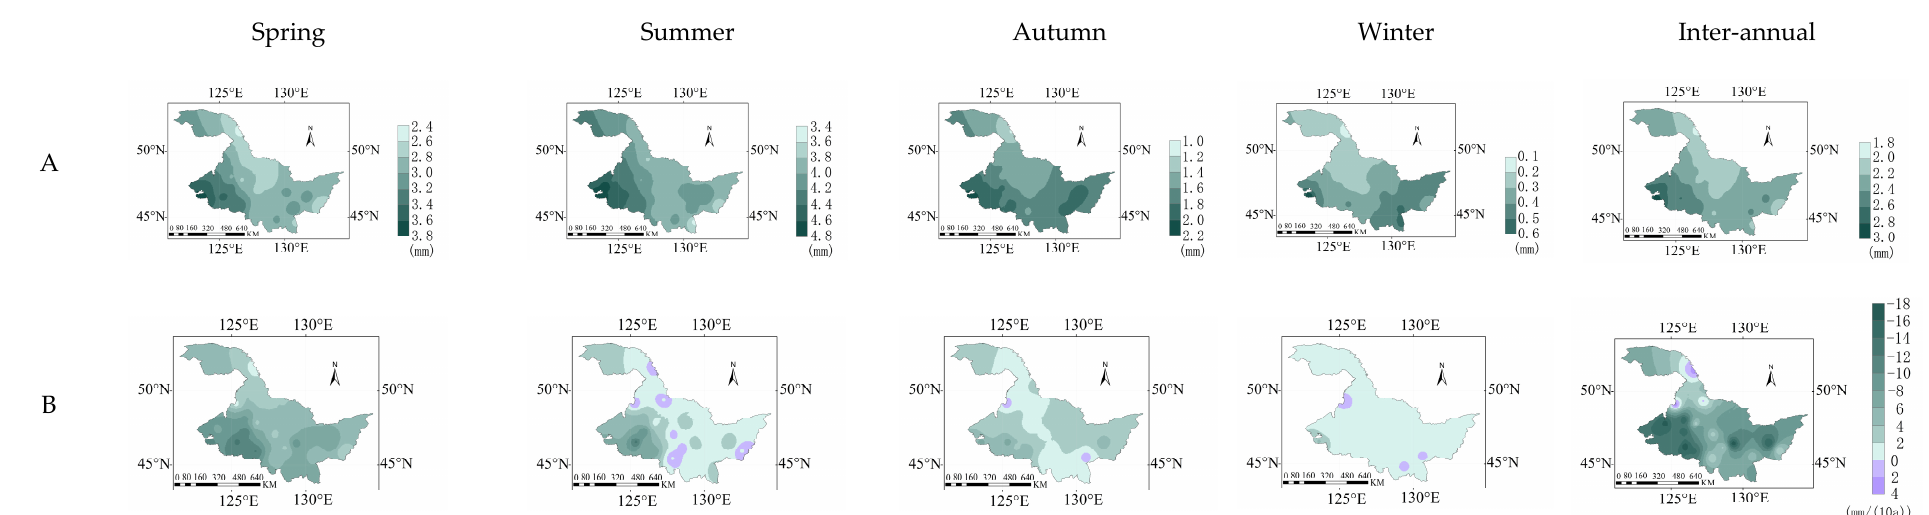
Figure 4. ( Row A ) spatial distribution and ( Row B ) climate tendency of ET 0 from 1960 to 2019.